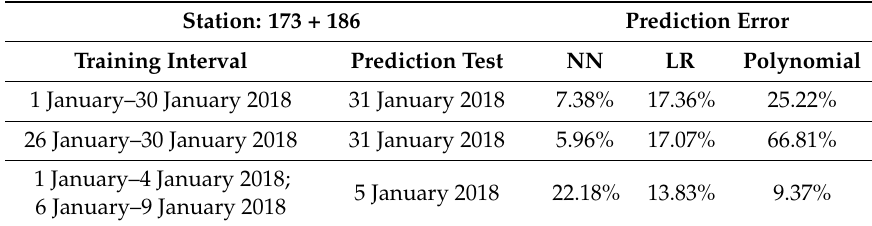
Table 10. Task 3: prediction error of the sensor attribute r_inc coming from both 173 and 186 monitoring station using neural network, and linear and polynomial regression machine learning models trained with different time-series interval for the training on the IoT Sensors dataset.